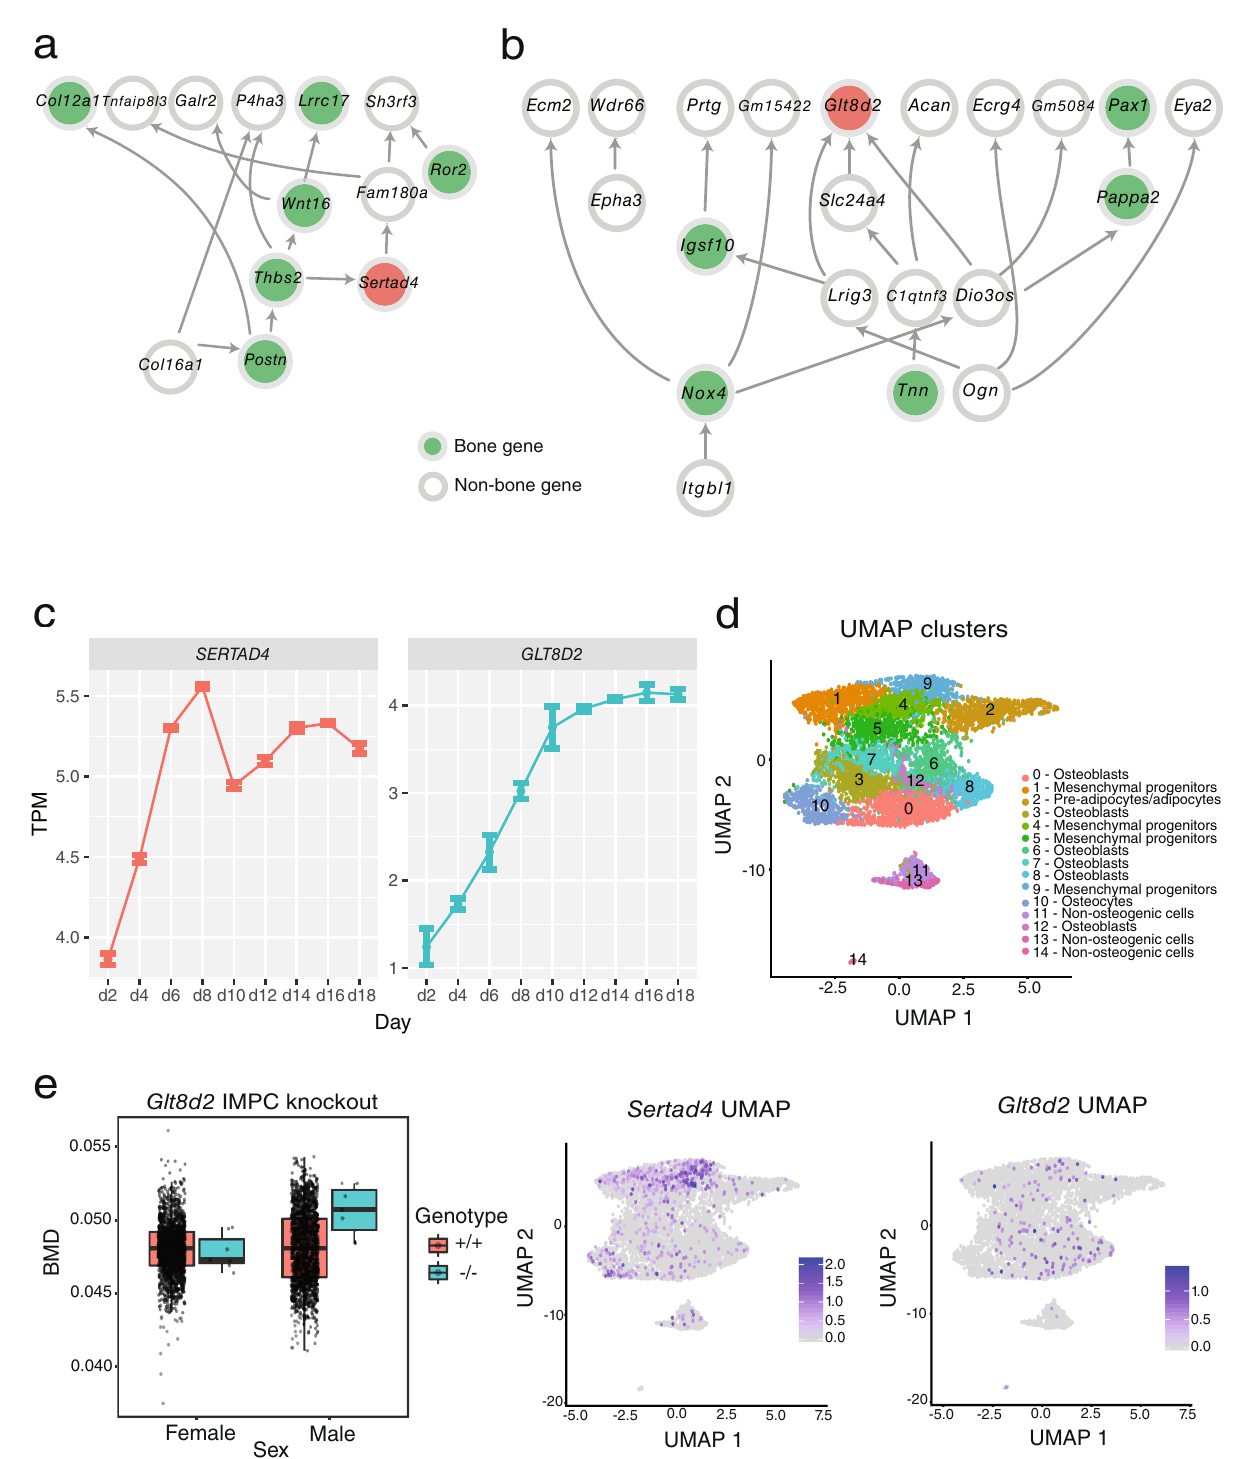
Fig. 4 Identifying SERTAD4 and GLT8D2 as putative regulators of BMD. a Local 3-step neighborhood around Sertad4 . Known bone genes highlighted in green. Sertad4 highlighted in red. b Local 3-step neighborhood around Glt8d2 . Known bone genes highlighted in green. Glt8d2 highlighted in red. c Expression of Sertad4 and Glt8d2 in calvarial osteoblasts. For each time point, N = 3 independent biological replicates were examined. Error bars represent the standard error of the mean. TPM transcripts per million. d Single-cell RNA-seq expression data. Each point represents a cell ( N = 7092 cells). The top panel shows UMAP clusters and their corresponding cell-type. The bottom two panels show the expression of Sertad4 and Glt8d2 . The color scale indicates normalized gene expression value. e Bone mineral density in Glt8d 2 knockout mice from the IMPC. N = 7 females and N = 7 males for Glt8d2 − / − mice, N = 1466 females and N = 1477 males for Glt8d2 + / + mice. Boxplots indicate the median (middle line), the 25th and 75th percentiles (box) and the whiskers extend to 1.5 * IQR. Colors indicate